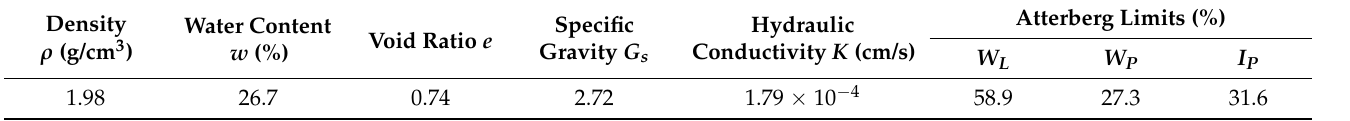
Table 1. Physical parameters of the granite residual